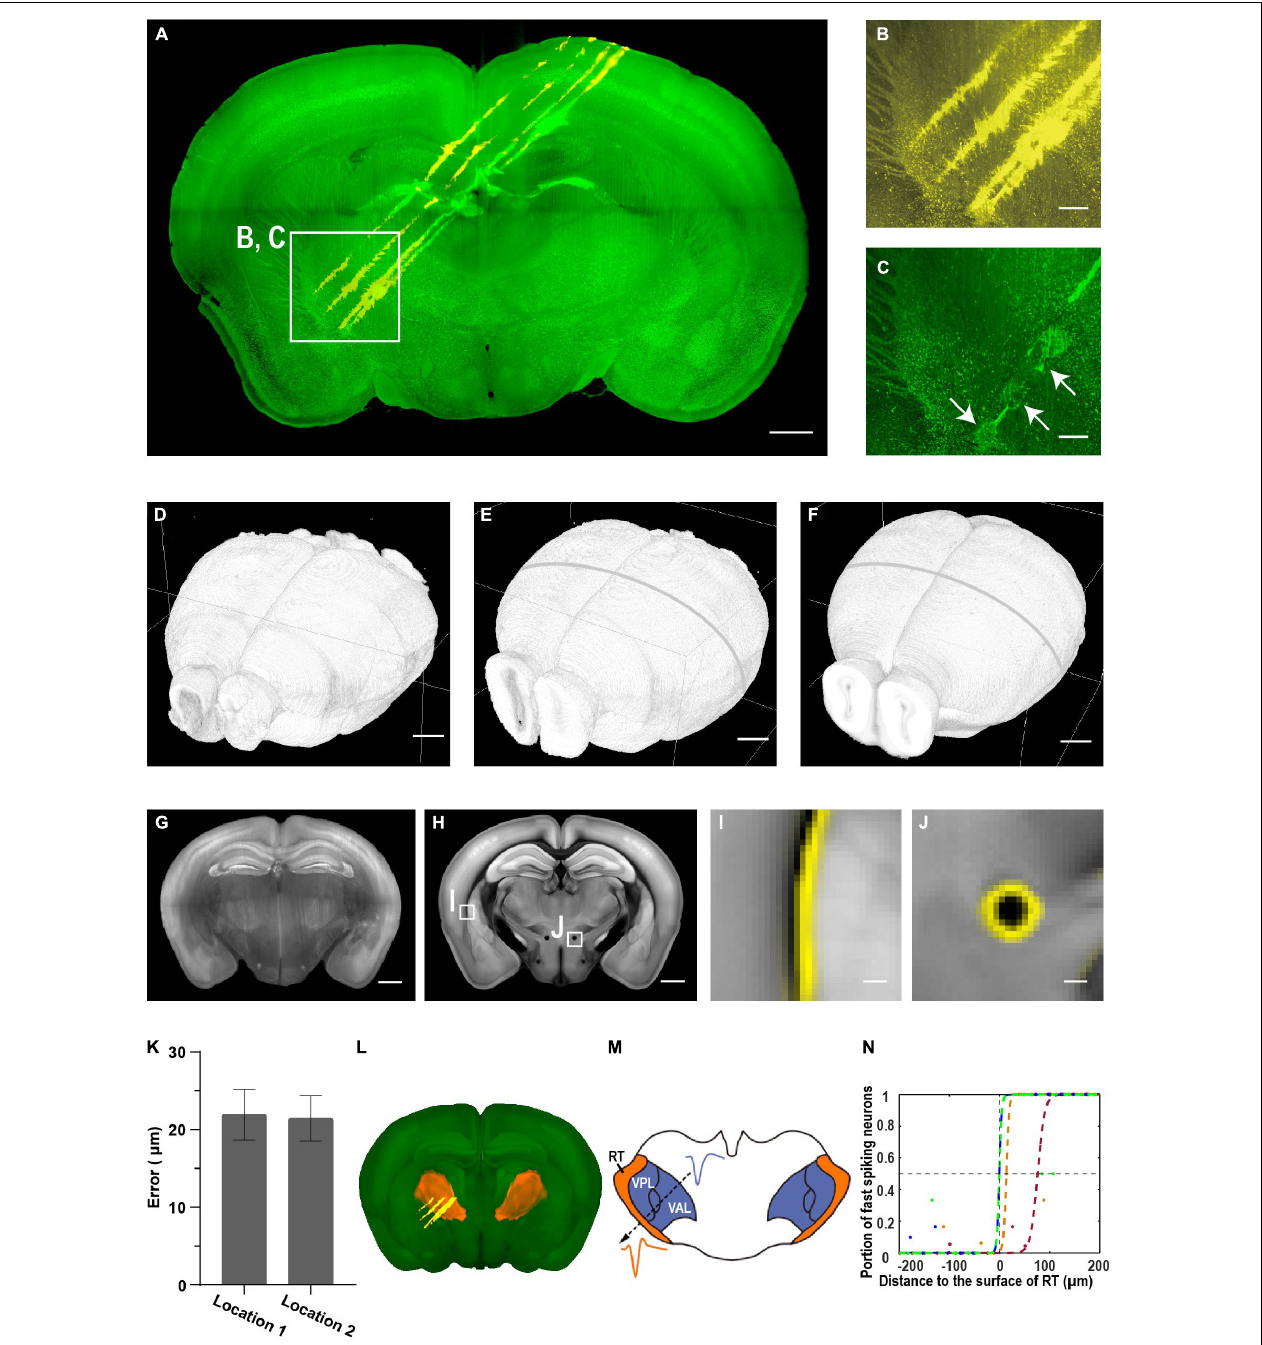
FIGURE 8 | Brain-wide imaging to reconstruct recording locations. (A) Schematic of recording from regions near thalamic reticular nucleus (TRN). Two-color imaging was performed to visualize electrode tracks (yellow) and lesion sites (green). Similar results in three of the samples. (B,C) Enlarged view of the white rectangular region in (A) . Arrows point to three lesion sites. Scale bars, 1 mm (A) , 50 µ m (B,C) . (D–F) Surface rendering of images before registration, after registration to the CCF template, and the CCF template. (G) Representative coronal slice of the registered brain. Scale bar, 1 mm. (H) Corresponding coronal slice of the Allen Reference Brain. Scale bar, 1 mm. (I,J) Enlarged view of the boxed regions in (F) showing nice match between the registered brain and the reference brain. (I) Optic and auditory radiation. (J) The mammillothalamic tract. Yellow, boundaries of registered brain. Scale bar, 100 µ m. (K) Average registration error of boundaries in (I,J) . Error bar, SEM ( n = 3 for each). (L) Surface rendering of TRN in the CCF template. (M) Example waveforms of neurons from TRN and neighboring thalamic nuclei. (N) Portion of narrow spiking neurons increases along the electrode track into TRN. Distance to the boundary at half probability of finding narrow spiking neurons is 22 ± 18 µ m (mean ± SEM, n = 4). Colored dots, data along different tracks. Colored lines, sigmoid fitting.